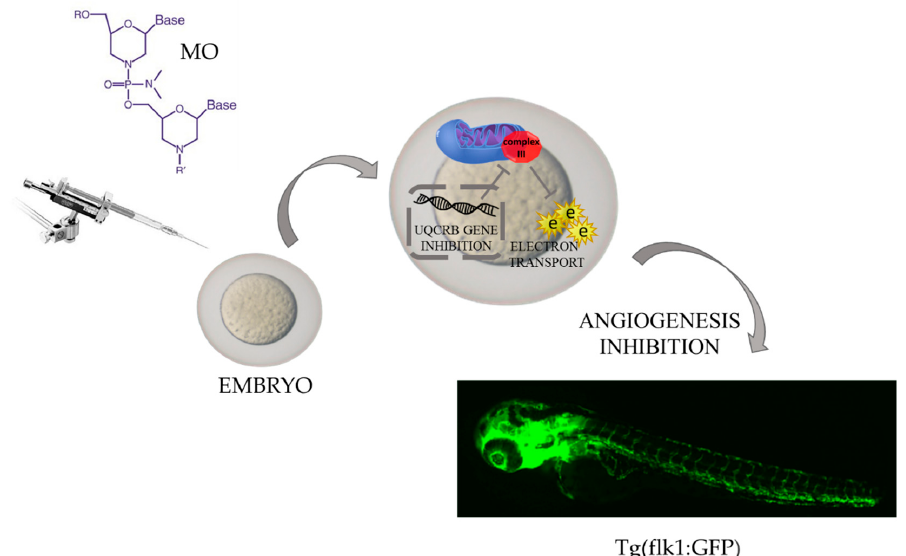
Figure 3. Oligonucleotide-based tools for studying gene function in zebrafish. The role of the gene- encoding ubiquinol cytochrome c reductase binding protein (UQCRB) in angiogenesis. E—electron, MO—morpholino oligonucleotides; Tg{flk1:GFP)—transgenic zebrafish line; UQCRB—ubiquinol– cytochrome c reductase binding protein (the mitochondrial complex III) (based on results shown by Cho YS et al.)